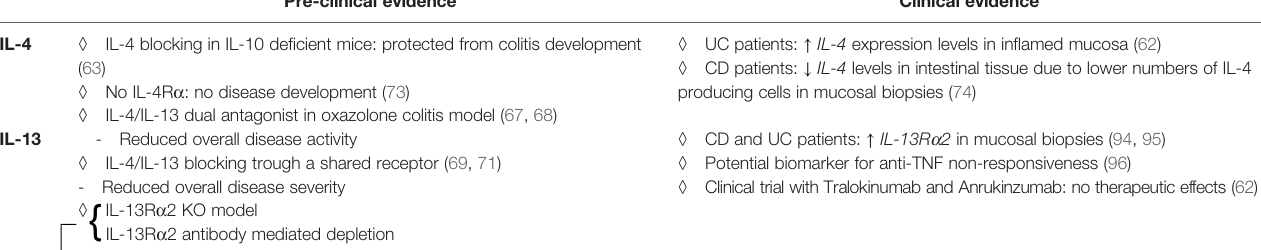
IL-13R a 2 antibody mediated